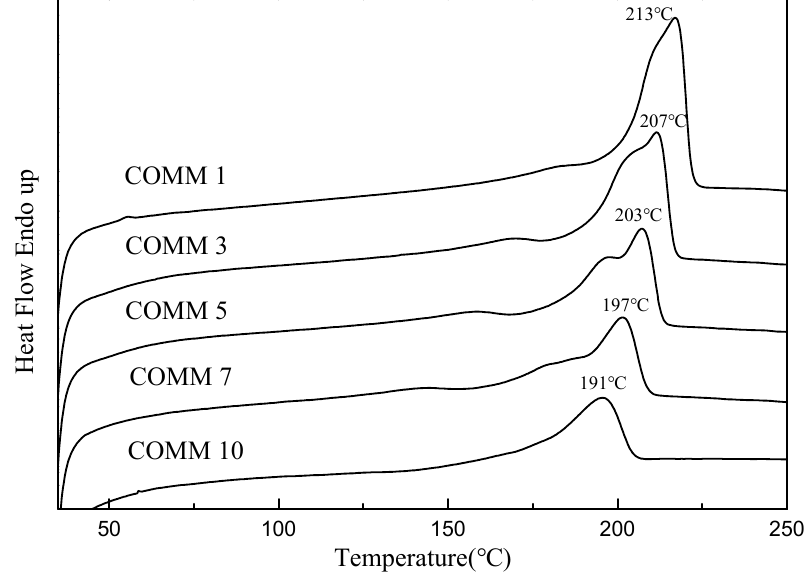
Figure 9. DSC of PA6 containing dimer oleic acid and 4,4'-Methylenebis(2-methylcyclohexylamine). Table 5. Thermal properties of PA6 containing dimer oleic acid and 4,4'-Methylenebis(2- methylcyclohexylamine).